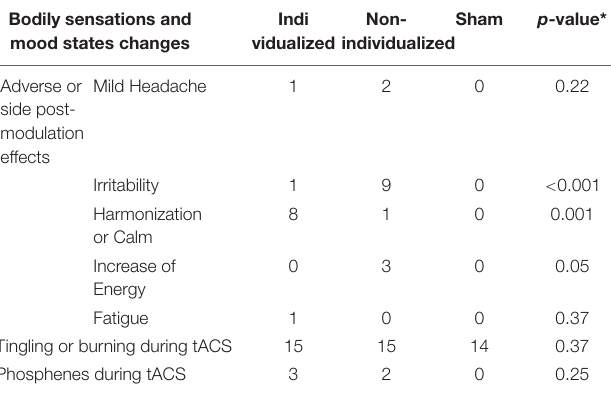
Indi vidualized